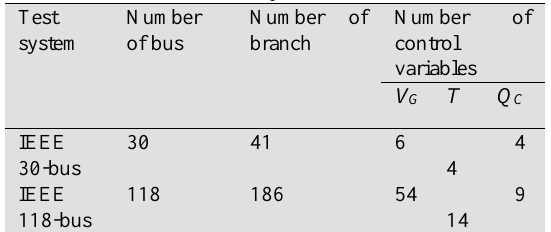
Table 1. Control variables of IEEE 30-bus and IEEE 118-